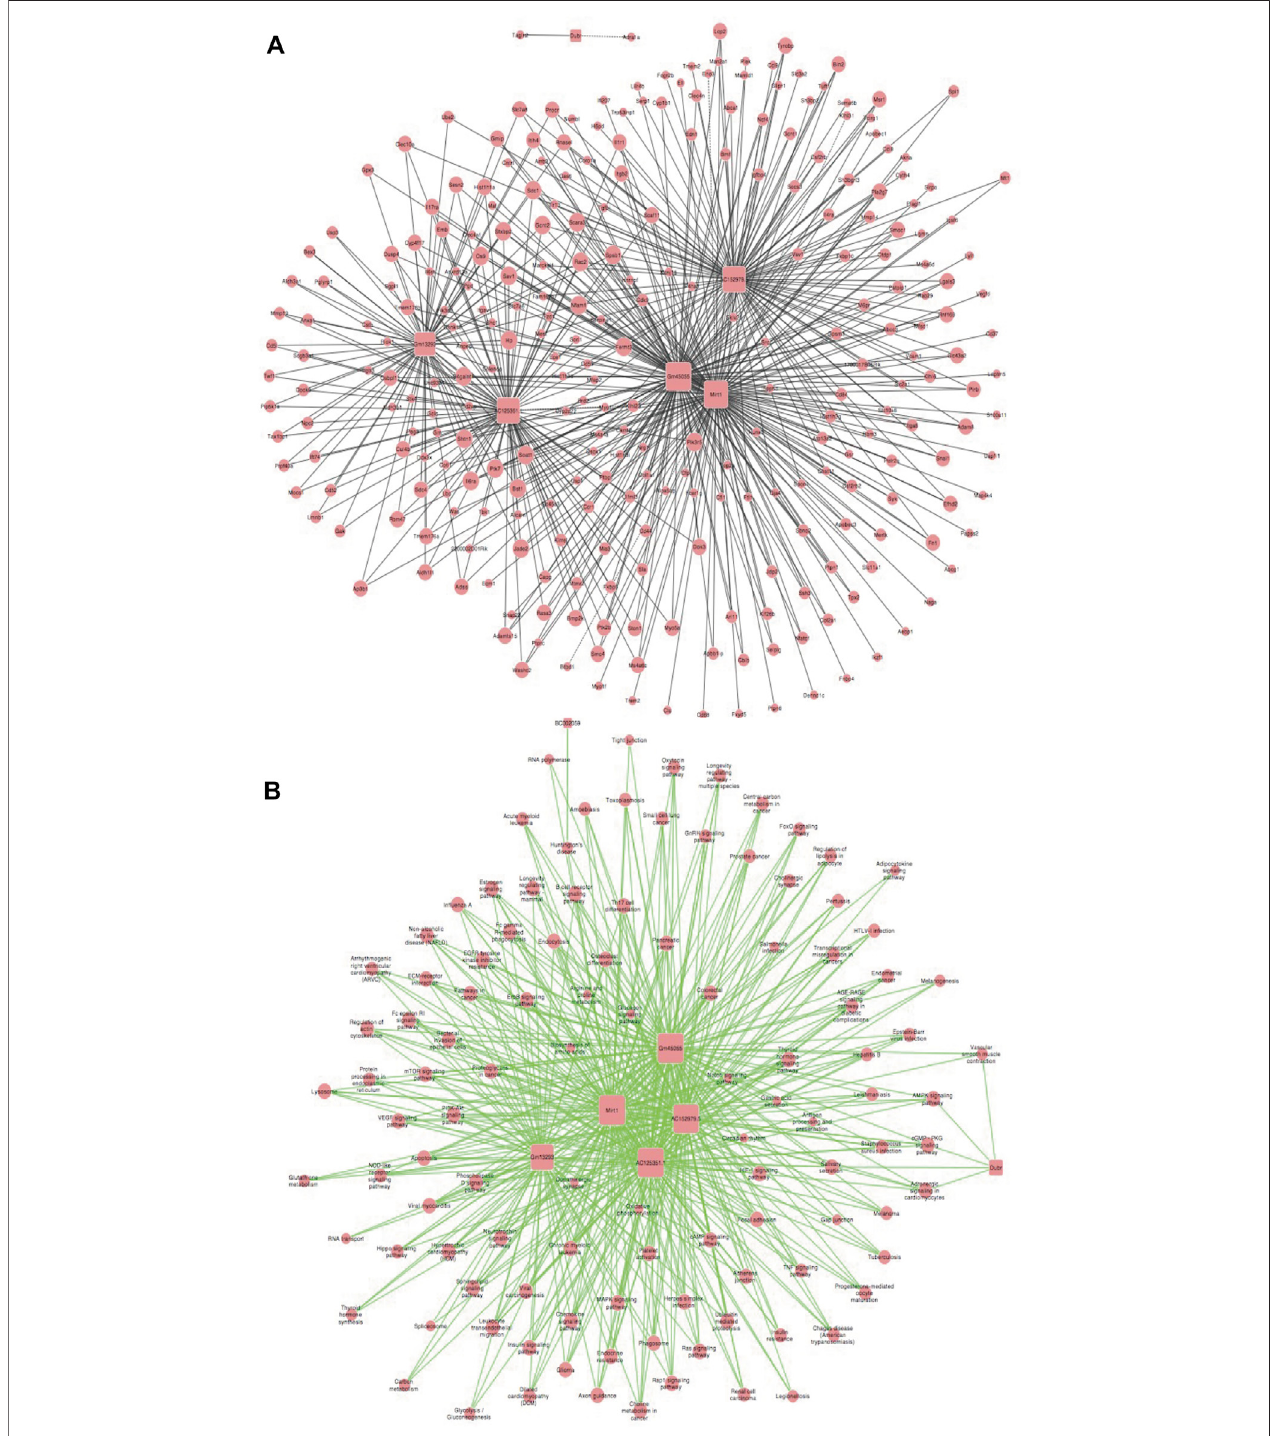
FIGURE 5 | LncRNA-mRNA co-expression correlation network and target pathway network of core lncRNAs. (A) LncRNA-mRNA expression correlation network analysis of core lncRNAs (Gm45055, Mirt1, AC152979.5, and AC125351.1) and their correlated mRNAs regulated by CIH post-MI. Square nodes and round nodes represent lncRNAs and mRNAs. The lines between nodes indicate a correlation, with a solid line representing positive correlation and a dotted line representing a negativecorrelation.Thesizeofnode represents thecorrelationstrength. (B) NetworkofthecorelncRNAs (Gm45055, Mirt1, AC152979.5,andAC125351.1)and target pathways. Square nodes represent lncRNAs, round nodes represent pathways, and relationships between them are represented by edges. The size of node represents the correlation strength.